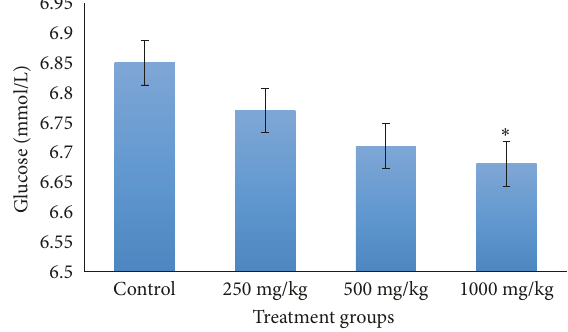
Figure 5: The effects of different concentrations of pomelo methanolic extracts on blood glucose levels. Results are expressed as mean ± SD (n=8). ∗ denotes level of significant difference when compared to control group (p < 0.05) as determined by using a one- way ANOVA followed by Dunnett’s multiple comparison